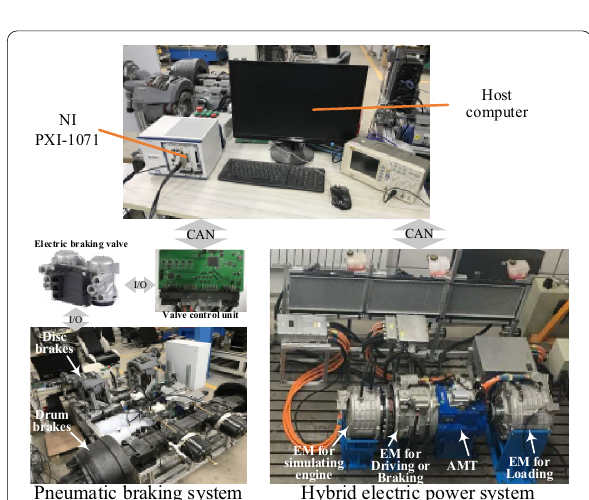
Figure 13 Test bench of the braking system